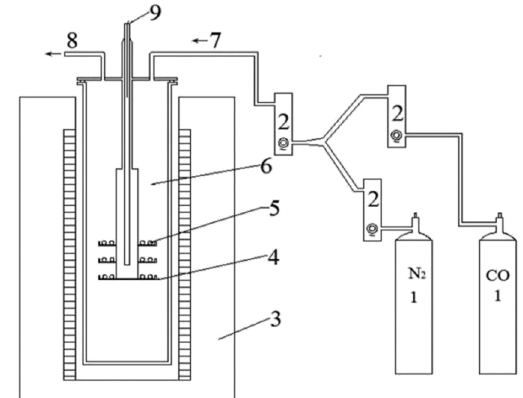
Figure 2: Schematic diagram of experimental devices for the reduction swelling experiment ( 1, gas cylinder; 2, fl ow meter; 3, blender; 4, reduction furnace; 5, specimens; 6, thermocouple; 7, gas inlet; 8, gas outlet; 9, reduction tube; 10, experimental vessels )